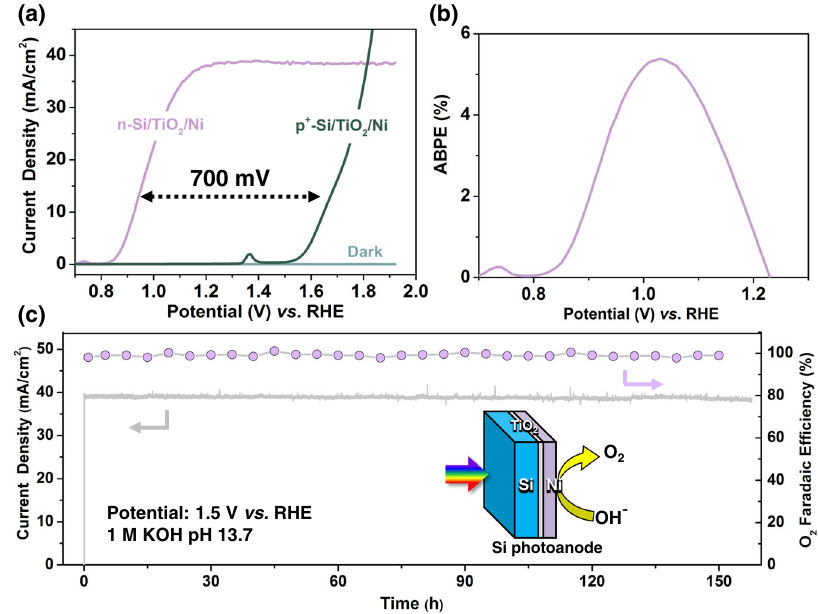
Fig. 2 | Performance ofback-illuminatedSi photoanode.a The current-voltage curves, b ABPE and c Time-dependent photocurrents (left-axis) and Faradaic ef fi ciency toward O 2 (right-axis) under simulated AM 1.5G illumination. Inset: Schematic of the light absorption and reaction decoupled Si